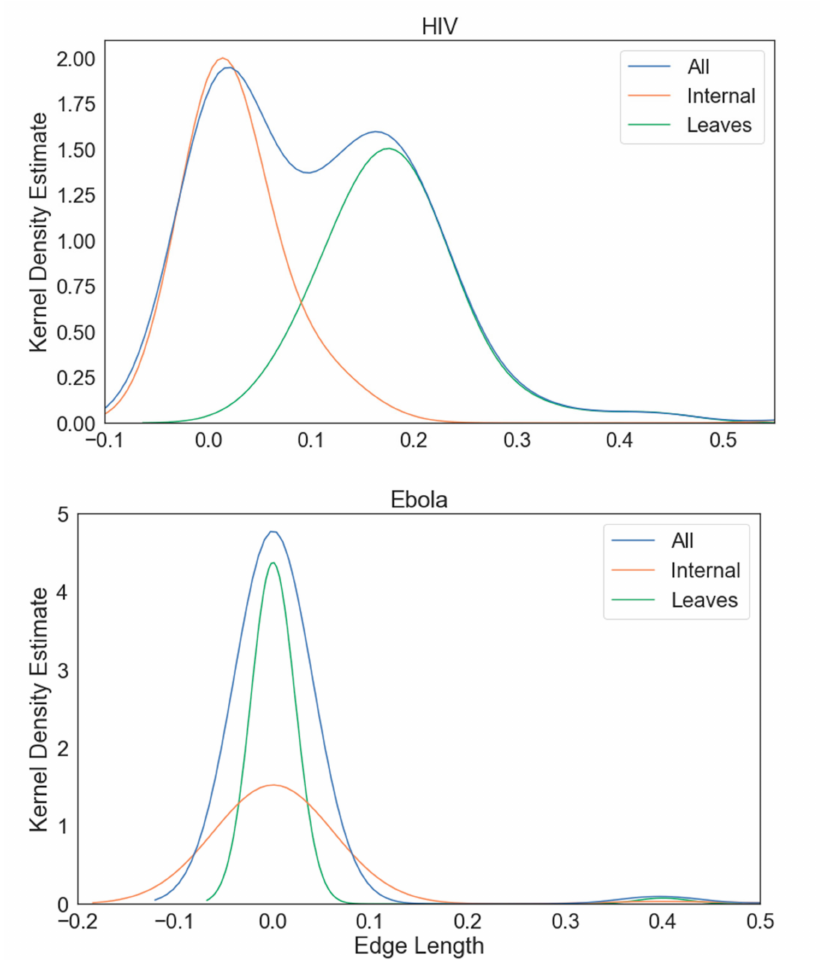
Figure 1. Kernel density estimates of the branch length distributions for the Ebola, HIV, and HCV true